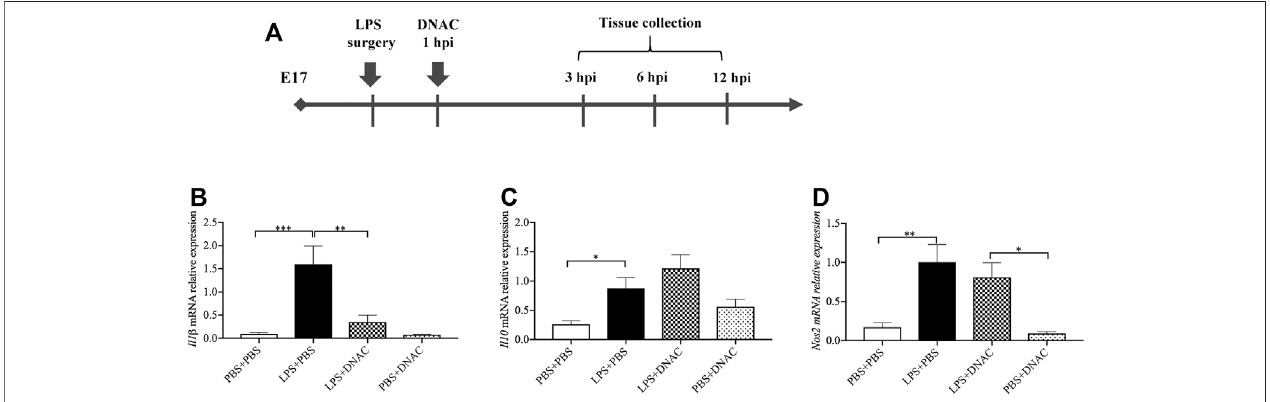
FIGURE1| Measurementsofin fl ammatorycytokineexpressionatmRNAlevelinplacentafollowingexposuretointrauterinein fl ammationandmaternalDendrimer- based N-Acetyl Cysteine (DNAC) treatment. (A) Study Strategy. At embryonic (E) day 17, pregnant CD-1 mice underwent a mini-laparotomy in the lower abdomen for intrauterine injection of lipopolysaccharide (LPS). One hour later, dams received intraperitoneally injection of DNAC or phosphate-buffered saline (PBS). At 6 h post injection (hpi) dams were sacri fi ced. Placentas were harvested from each dam and quantitative polymerase chain reaction (QPCR) was performed to evaluate the